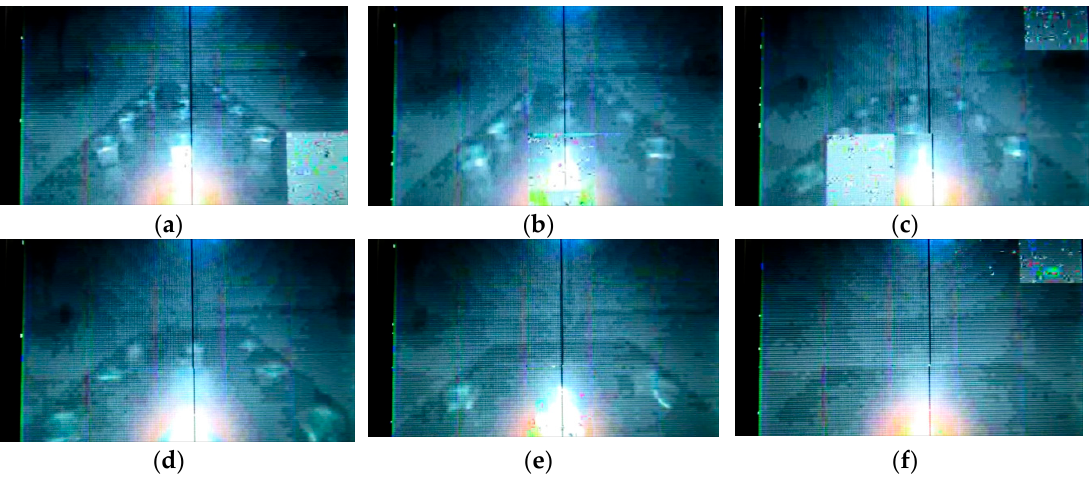
Figure 17. Images of camera attached to the front of BIREM with the control. ( a ) 0 s; ( b ) 2 s; ( c ) 4 s; ( d ) 6 s; ( e ) 8 s; ( f ) 10 s.